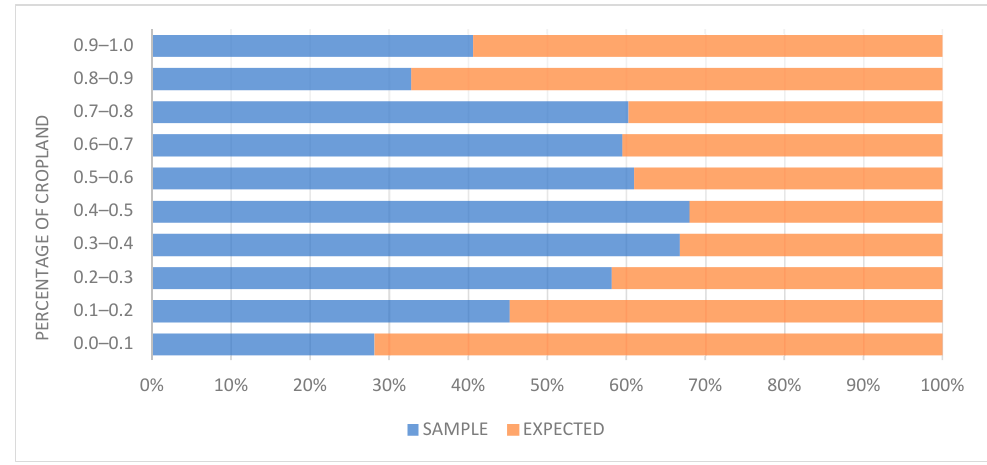
Figure 9. Percentage of Observed (~Sample) vs. Expected Counts for Cropland Variable.